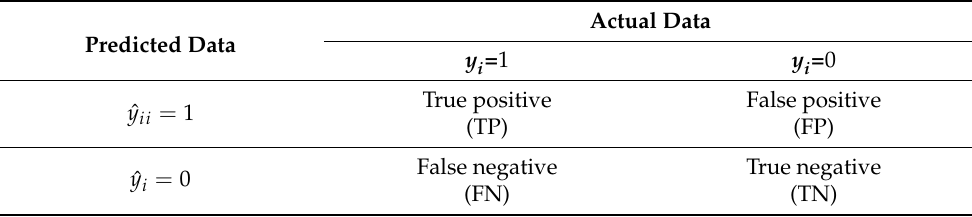
Table 1. The confusion matrix of actual data ( y i ) and predicted data ( ˆ y i ).